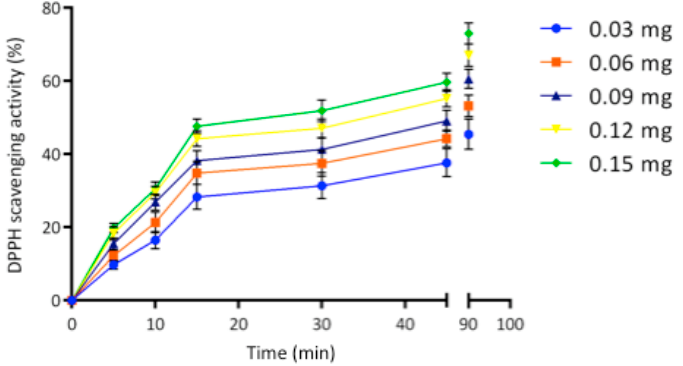
Figure 7. 2,2-diphenyl-1-picrylhydrazyl (DPPH) scavenging activity of different concentrations of egagropili lignin fraction during 90 min of incubation of samples at room temperature and dark. Further experimental details are given in the text.